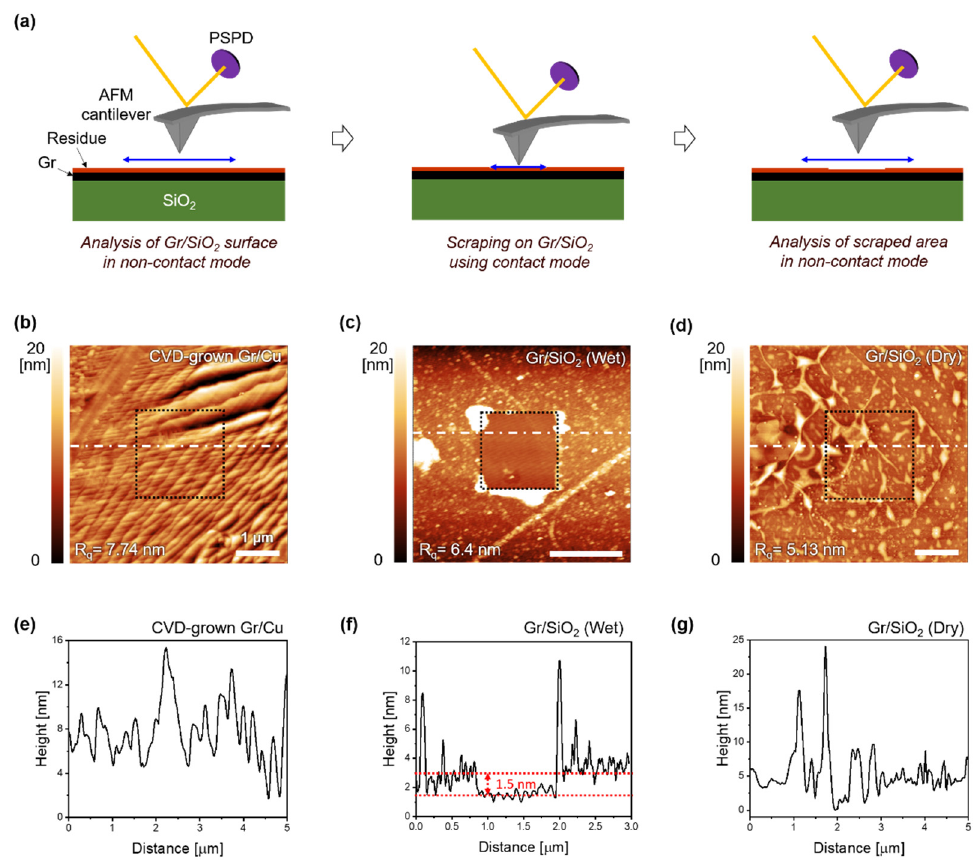
Figure 3. ( a ) Schematic diagram of the residue check procedure using an atomic force microscope. Topography images of ( b ) Gr/Cu, ( c ) wet-transferred Gr/SiO 2 , and ( d ) dry-transferred Gr/SiO 2 . Line profiles on the white dotted line in ( b – d ) of ( e ) Gr/Cu, ( f ) wet-transferred Gr/SiO 2 , and ( g ) dry-transferred Gr/SiO 2 . AFM: atomic force microscopy.